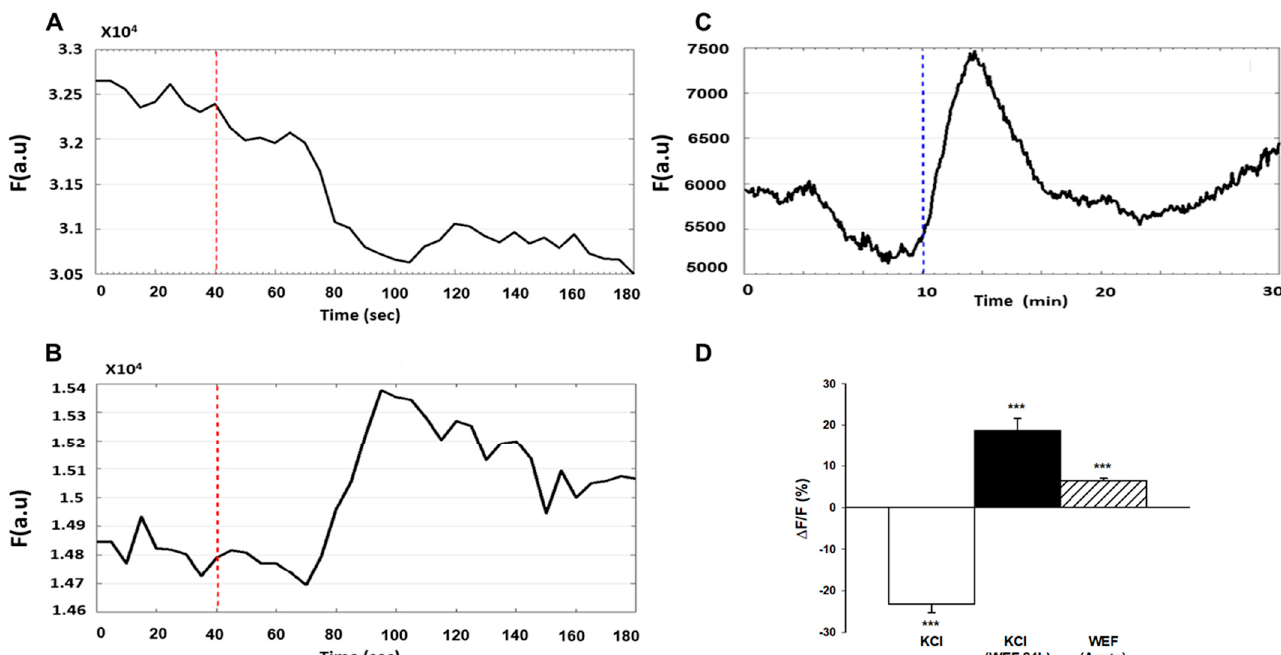
Figure 3. Effect of WEF on membrane potential of myotubes. Cells loaded with di-8-ANEPPS for 3 min were washed and followed for 3–30 min. ( A ). Representative trace of a control cell exposed to KCl (150 mM) at the time indicated (dashed line). Downward deflection represents depolarization. ( B ). Representative trace of cell exposed to WEF for 24 h, followed by interruption of ~10 min (for loading with di-8-ANEPPS and focusing in microscope), and then again exposed to WEF before addition of KCl at the time indicated (dashed line). Upward deflection represents hyperpolarization. ( C ). Representative trace of cell exposed to WEF for 24 h, followed by interruption of ~20 min (for loading with di-8-ANEPPS, focusing in microscope, and allowing for stabilization of baseline), before exposing to WEF as indicated (dashed line). ( D ). Mean ± SE values for 75 (KCl), 53 (KCl + WEF 24 h) and 7 (WEF acute) cells. *** p < 0.001 vs. 0.